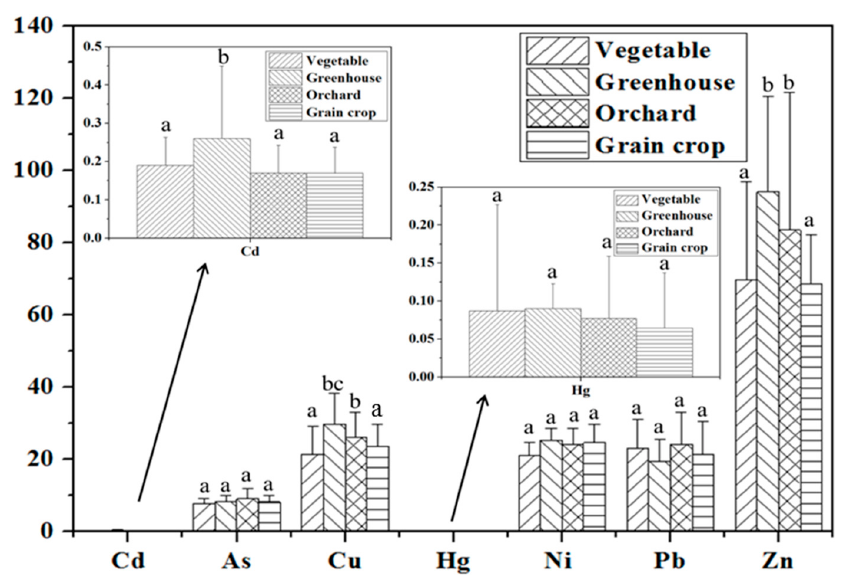
Figure 2. Heavy metals concentration in soils from different land use in soil (mg·kg − 1 ). Land uses followed by different letters (a, b, c) are significantly different at p < 0.05.